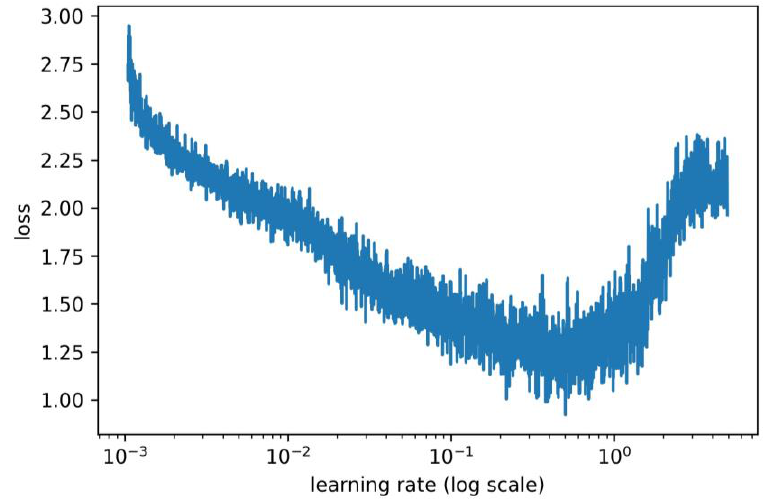
Figure 1. The curve of loss functions by learning rate range test on the CIFAR10 dataset (Smallnet). The x -axis is learning rate, and the y -axis is training loss.